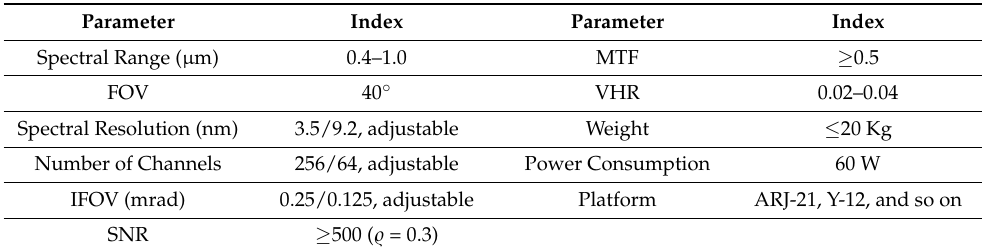
Table 3. Main features of the WiSHiRaPHI